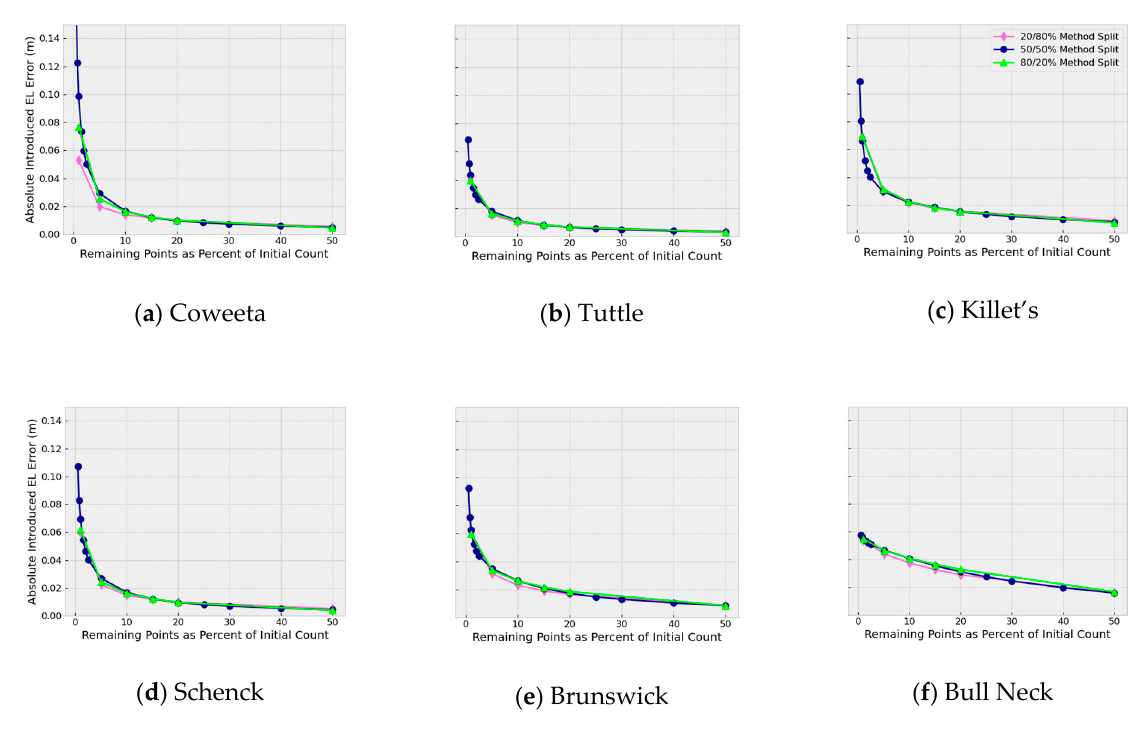
Figure 12. Method split comparisons by absolute introduced error value.